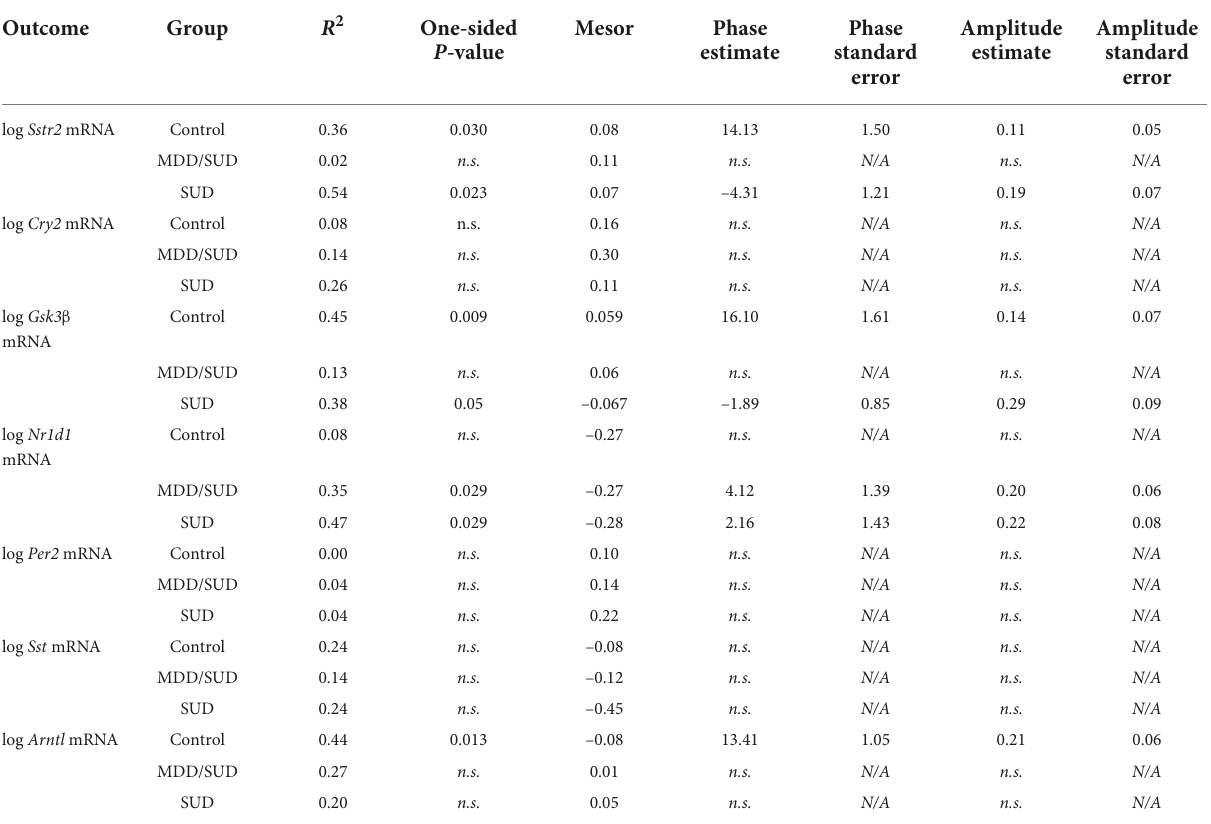
TABLE 3 Table of diurnal rhythm analysis